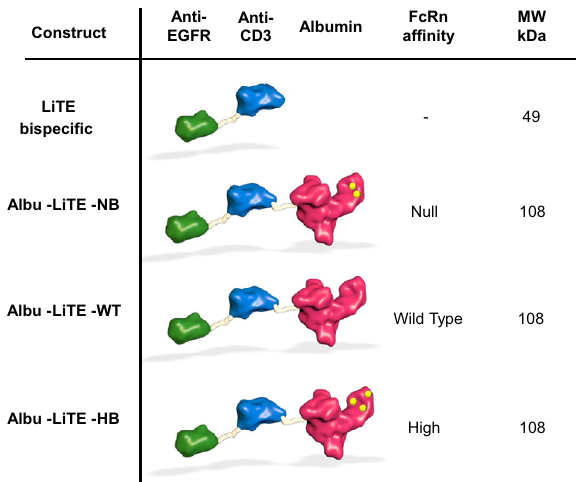
Fig. 1 Schematic overview of designed Albu-LiTE constructs. The bispeci fi c LiTE molecule (49 kDa) containing an anti-EGFR nanobody (green) linked to anti-CD3 scFv (blue). HSA (red) and point mutationed variants (yellow dots) with different af fi nities for human FcRn were genetically fused with the LiTE and expressed as a single polypeptide